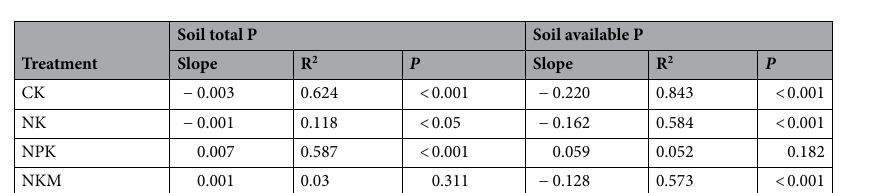
Figure 6. Variation and distribution of soil total P content ( A , B ) and soil available P content ( C , D ) in 0–15 cm layer under different fertilization treatments CK, NK, NPK and NKM across 35 years. Red lines in ( B , D ) indicate the mean value.